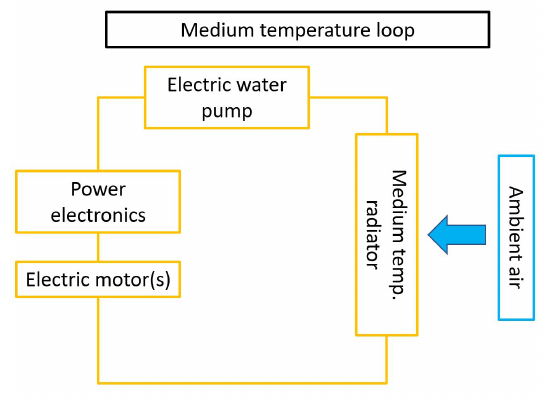
Figure 2. Scheme of a medium temperature loop.